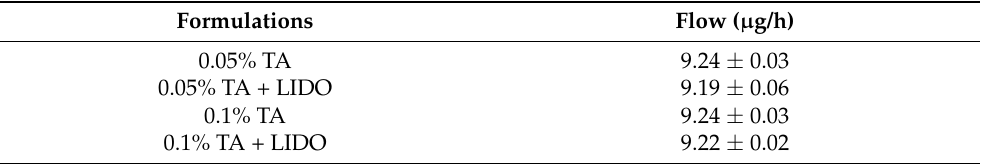
Table 3. Amount of TA permeated in buccal mucosa per hour (flow). Values represent Means ± SD ( n = 5). No significant differences were observed ( p <